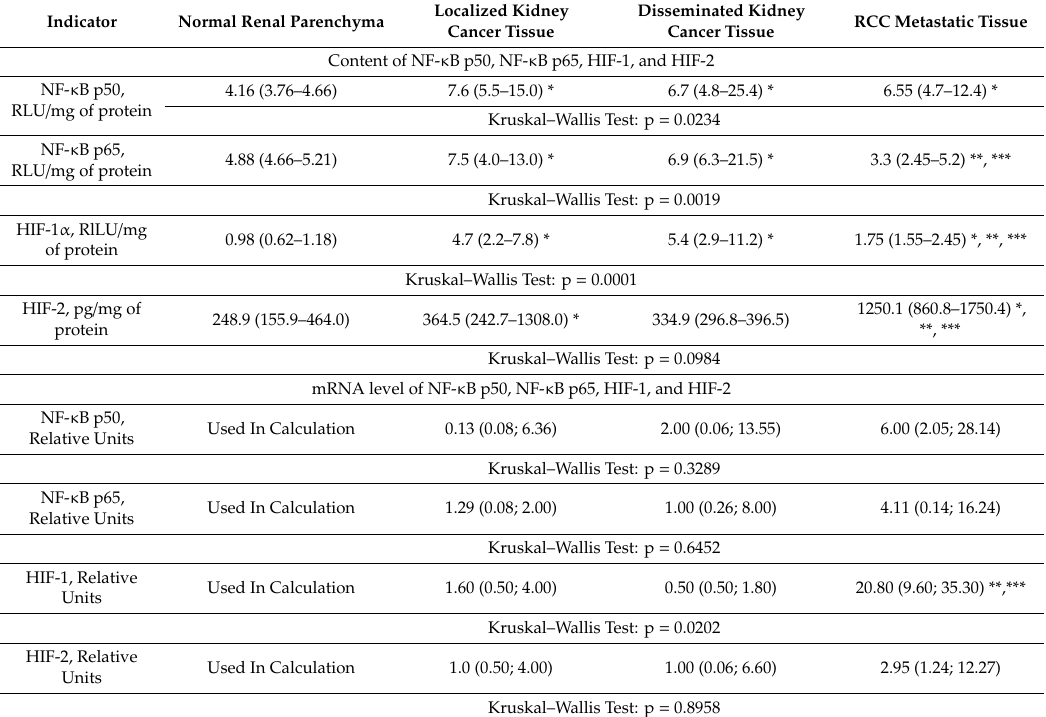
Table 2. The content and expression of NF-kB p50, NF-kB p65, HIF-1 and HIF-2 in patients with localized and disseminated kidney cancer, as well as in metastatic